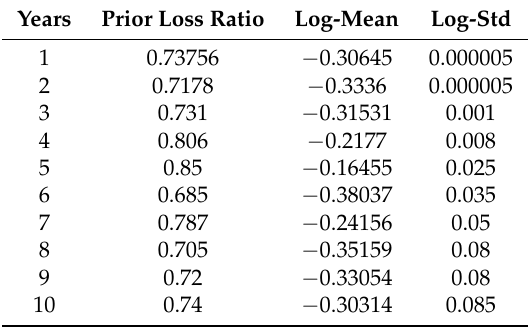
Table 2. We report the priors we elicited for each accident year. The older the accident year, the more evident is the final loss ratio and then the smaller the variability parameter. With respect to years 1 and 2, the variability is negligible as the final development years will have a non-significant effect on the final loss ratio. On the other hand, for the three youngest accident years, we opted for a quite wide